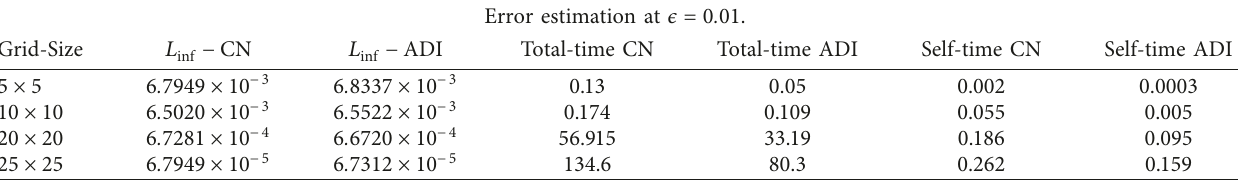
Table 3: Errors of CN and ADI at different gird sizes with k � 0 . 001 for unknown u ( p,q,t ) . Error estimation at ϵ � 0 . 01.